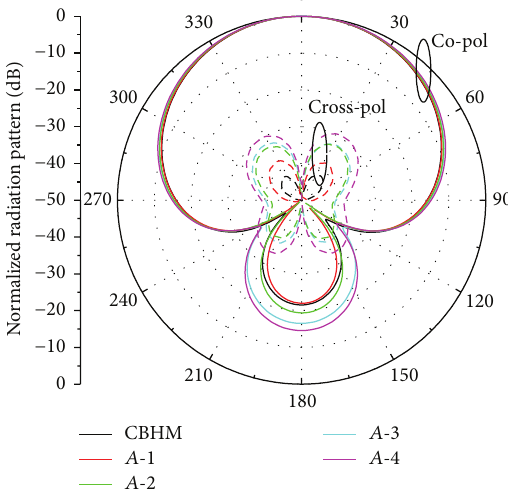
Figure 14: H -plane radiation patterns.